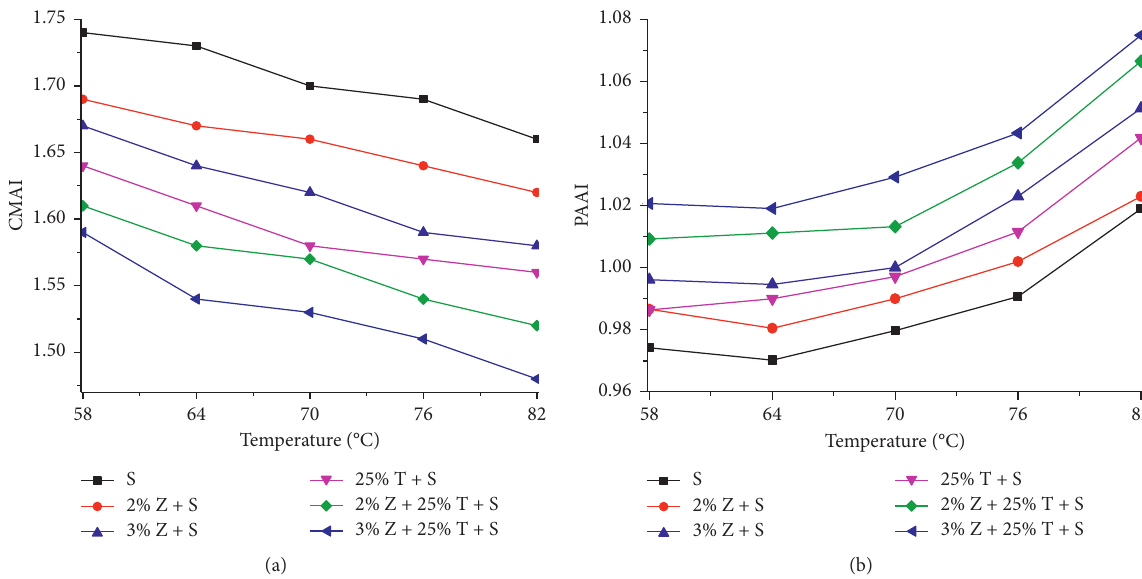
Figure 7: Effect of different content of nano-ZnO (Z) and TLA (T) on rheological properties of SBS asphalt (S) after short-term aging. (a) Complex modulus aging index for asphalt. (b) Phase angle aging index for